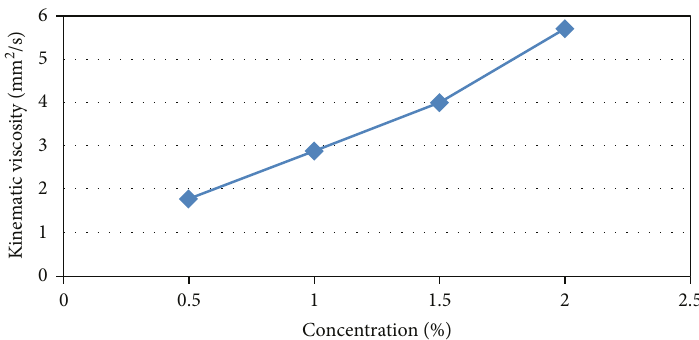
Figure 3: Kinematic viscosity of di ff erent pectin concentration from in vitro cultures of Fumaria o ffi cinalis. Table 4: Functional properties of pectin isolated from in vitro cultures of Fumaria o ffi cinalis . Swelling properties, Water-holding capacity (WHC), Fraction mL water/g sample 1 g water/g